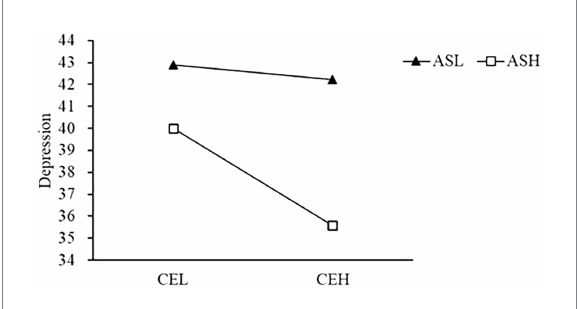
FIGURE 1 Moderated effect of rumination on the relationship between emotional empathy and depression. RRL, low rumination; RRH, high rumination; EEL, low emotional empathy; and EEH, high emotional empathy.